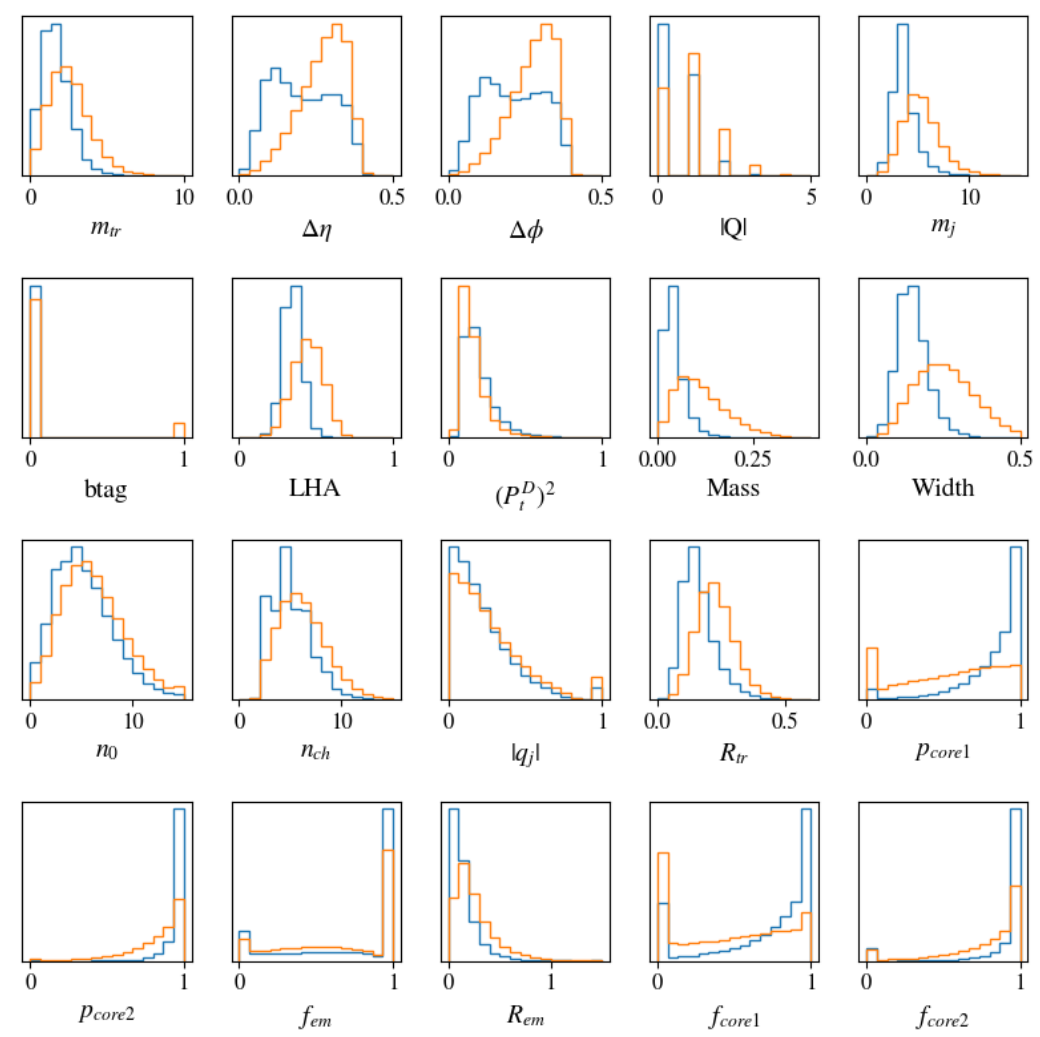
Figure 1: Distributions of the variables used for charmonium identification. Signal ( J /ψ ) in blue, background of a mixed sample of 50% quark and 50% gluon jets in orange. The distributions are normalized to